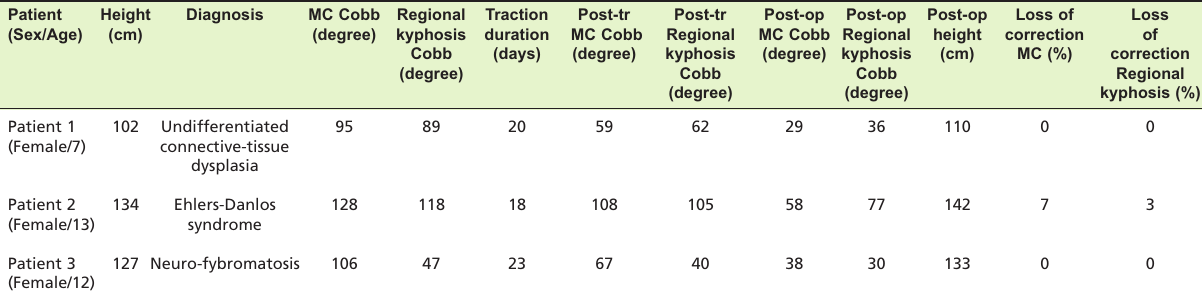
Operative- and post-operative clinical and radiologic data of the three patients with neuromuscular scoliosis Table I: Patient Height Diagnosis MC Cobb Regional Traction